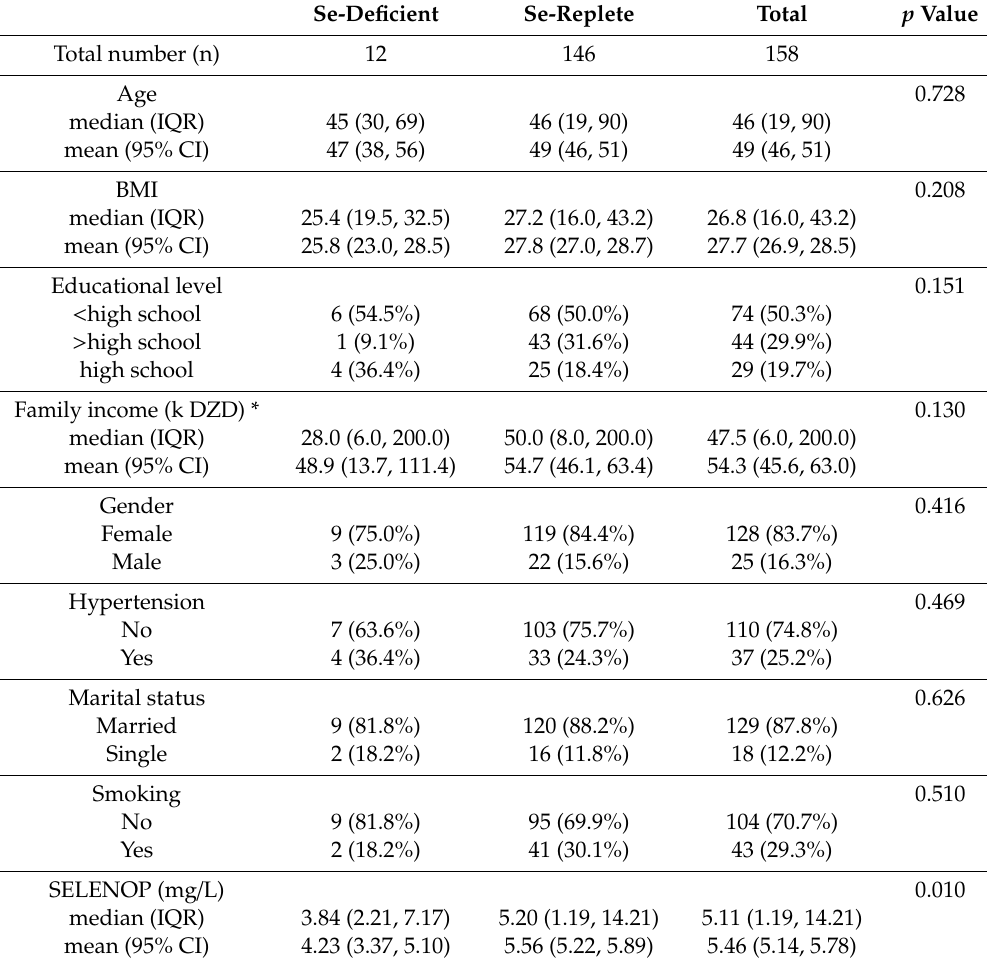
Table 1. Comparison of subjects classified as Se-deficient ([Se] < 70 µ g / L) or Se-replete. Se-Deficient Se-Replete Total p Value Total number (n) 12 146